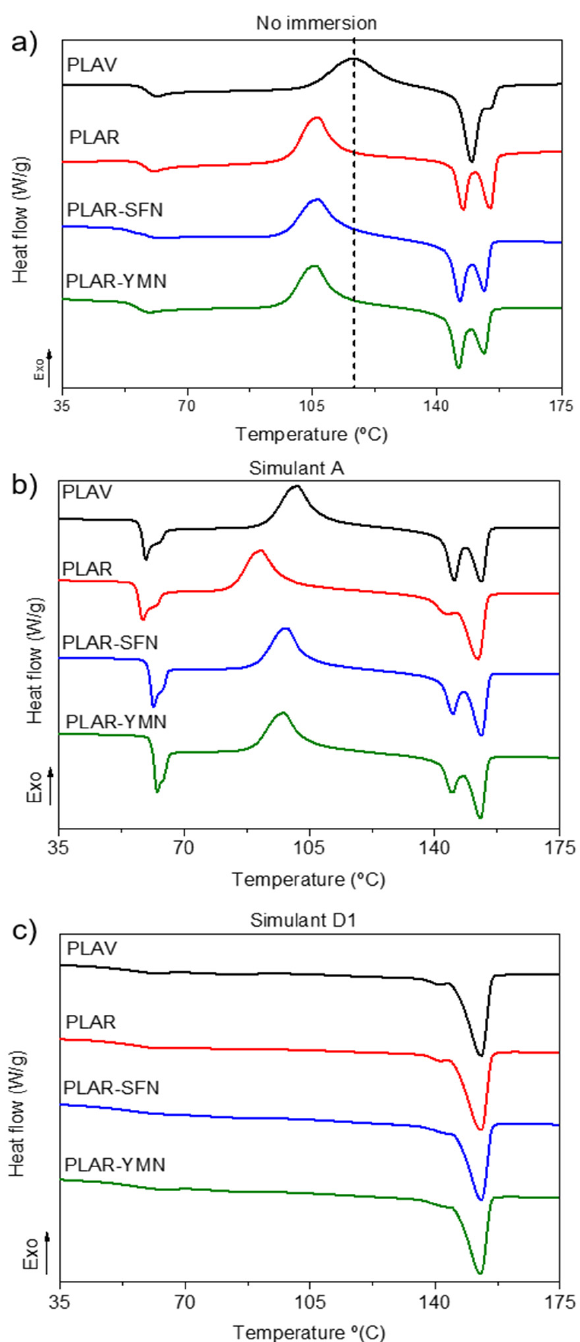
Figure 5. DSC first heating scans of the samples before ( a ) and after overall migration tests in food simulants: A (ethanol 10% v / v ) ( b ) and D1 (ethanol 50% v / v ) ( c ).